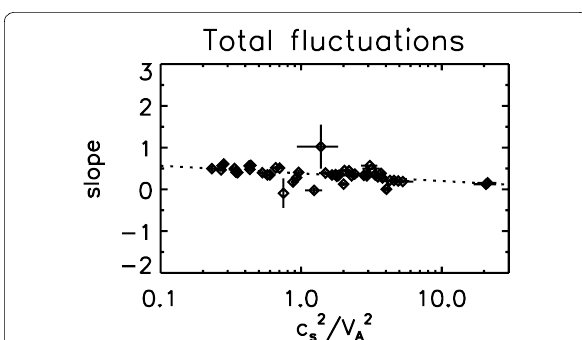
Fig. 3 Slope of the linear relation between the density fluctuation and the squared magnetic field fluctuation plotted as a function of c 2 V 2 β the beta-tilde parameter ( s / A ). The slope is evaluated using ˜ = the density fluctuation and the total magnetic field fluctuation (including both linear fluctuations and nonlinear fluctuations) by B 2 B 2 subtracting by the mean magnetic field, δ B 2 t 0 . The slope = − values are derived from the least square fitting: single response group in black, separate response group in diamond and gray, and overlapped response group in triangle and gray. Error bars indicated three-sigma for a confidence interval of about 95% both in the beta-tilde parameter and the slope